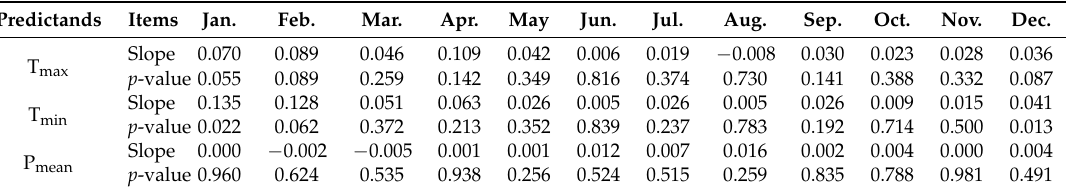
Table 3. Summary of downscaled weather predictands trend analysis (2015–2044).